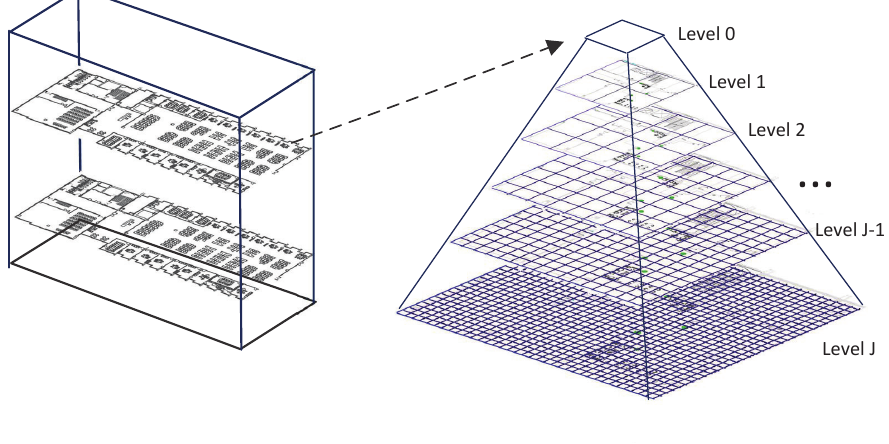
Figure 3. Illustration of the multi-resolution building